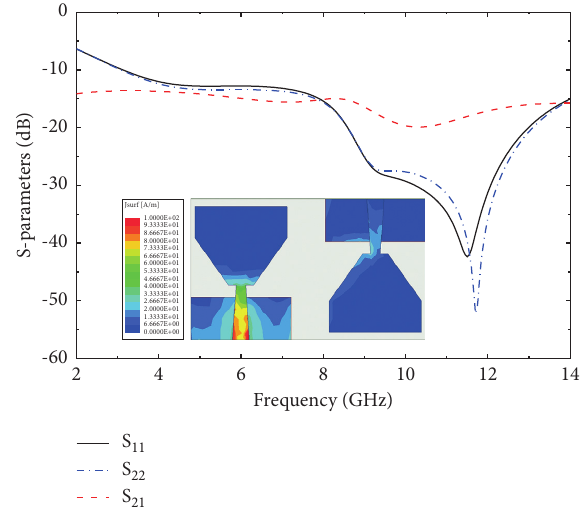
Figure 5: Simulated S -parameters of UWB MIMO antenna without loaded decoupling structure and the surface current dis- tribution under